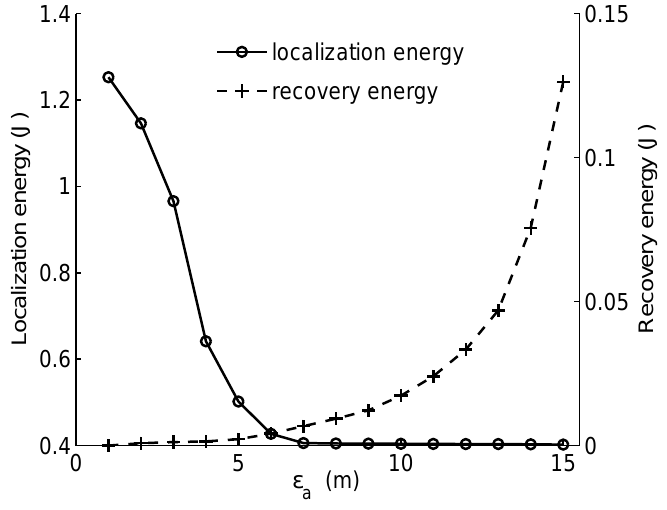
Figure 11 . Impact of localization error upper bound on energy